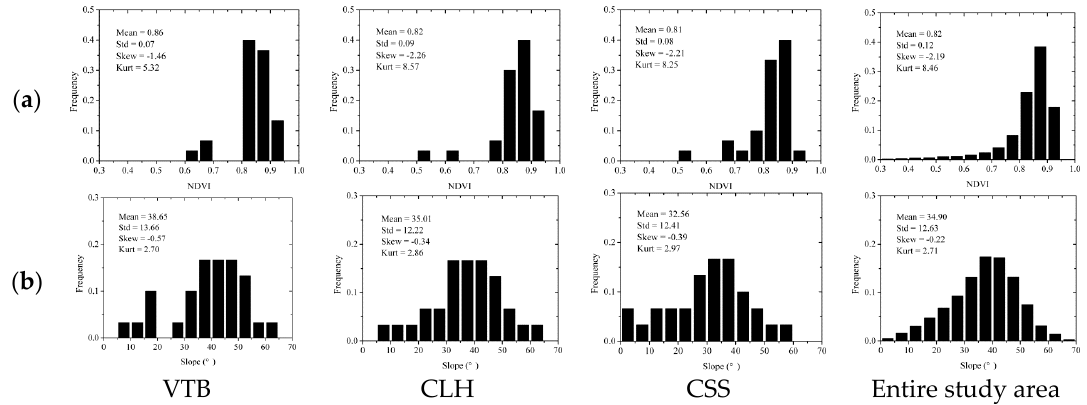
Figure 4. NDVI ( a ) and slope ( b ) frequency distribution histograms of 30 selected sampling plots given by VTB, CLH and CSS sampling strategies and of the entire study area. VTB, CLH, and CSS refer to vegetation type-based, traditional conditioned Latin hypercube, and cost-constrained sampling strategies, respectively.